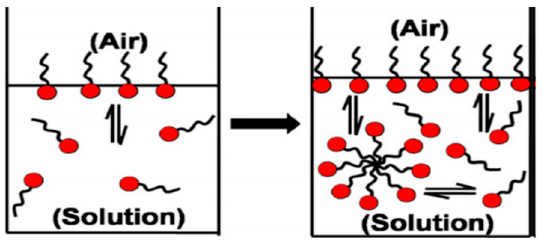
Figure 4. Schematic depiction of surfactant molecules aligning on water/air interface at pre- and post-‘Critical Nanomicelle Concentration (CNC)’ threshold (adapted with permission from Mukherjee et al. [68]).